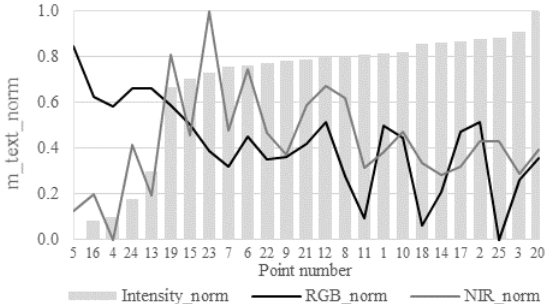
Figure 8. Summary of normalized texturing error values for the RGB and NIR images as a function of intensity of the matching points